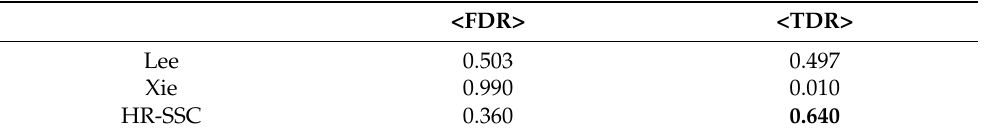
Table 8. Average FDR and TDR on the HSim-data —best results are in